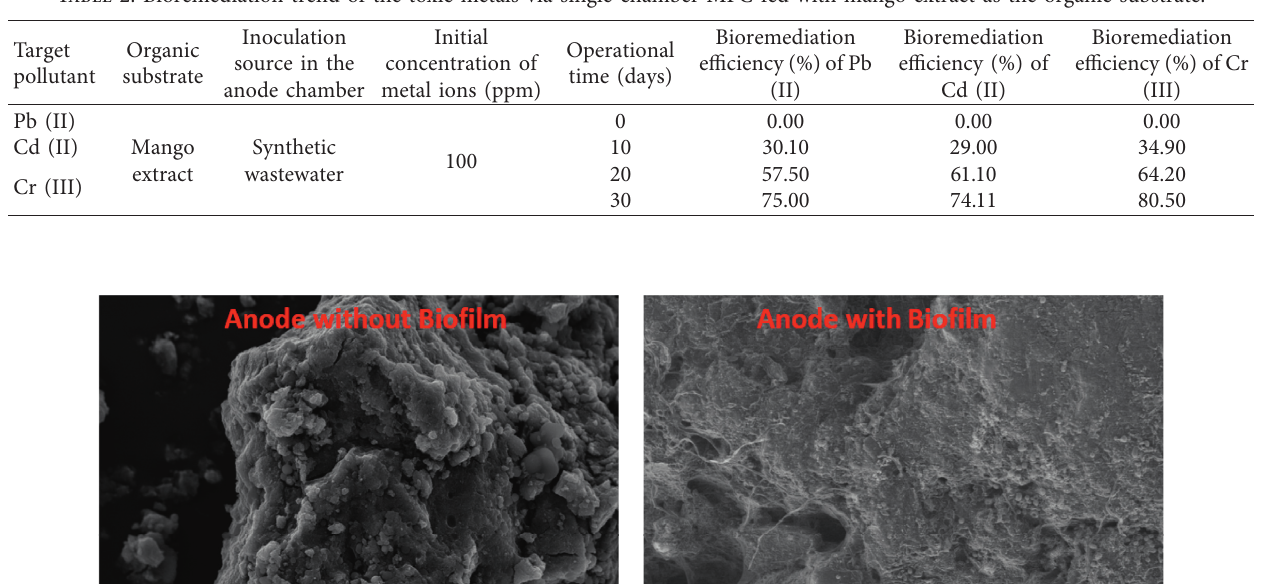
s values during the MFC operation.